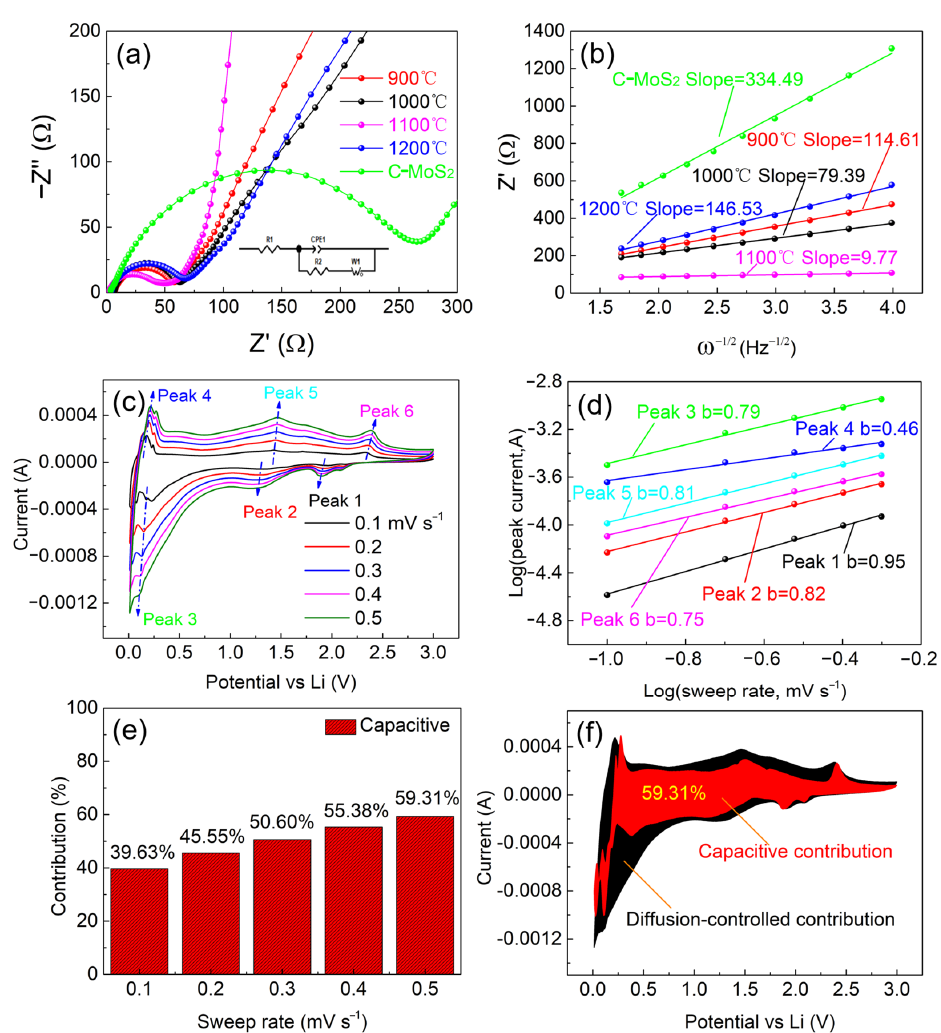
Figure 9. ( a ) AC impedance spectra of MoO 3 /MoS 2 @G and C ‐ MoS 2 electrodes. ( b ) The values of Z ′ vs. ω − 1/2 ( ω = 2 Π f) for MoO 3 /MoS 2 @G and C ‐ MoS 2 . ( c – f ): Contribution of pseudocapacitive Li ‐ ion storage to the total capacity of the MoO 3 /MoS 2 @G ‐ 1100 electrode: ( c ) CV curves with scan rates raging 0.1 to 0.5 mV s − 1 ; ( d ) the logarithmic dependence between the peak current and sweep